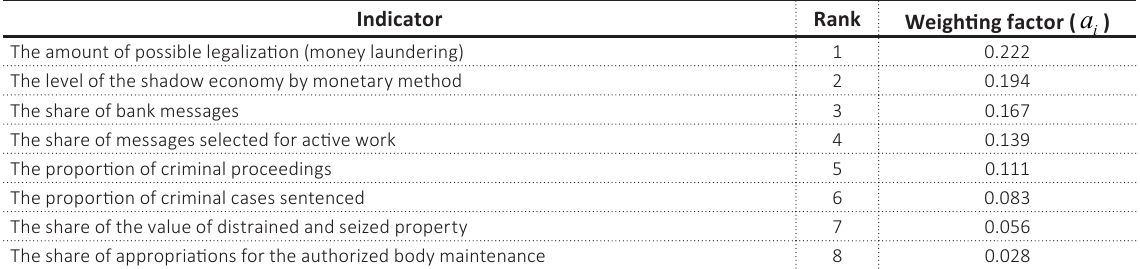
Table 4. Ranks and weights for determining the integral indicator of the effectiveness of the banking system financial monitoring